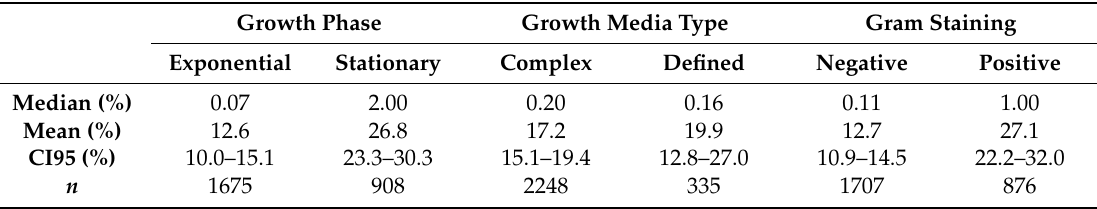
Table 3. Descriptive statistics for three of the variables measured for the incident of persisters in bacteria: The median, mean, and confidence interval 95% (CI95) were listed for the data grouped by growth phase, Gram staining, and growth media. The total number of data points collected from source are denoted as n .